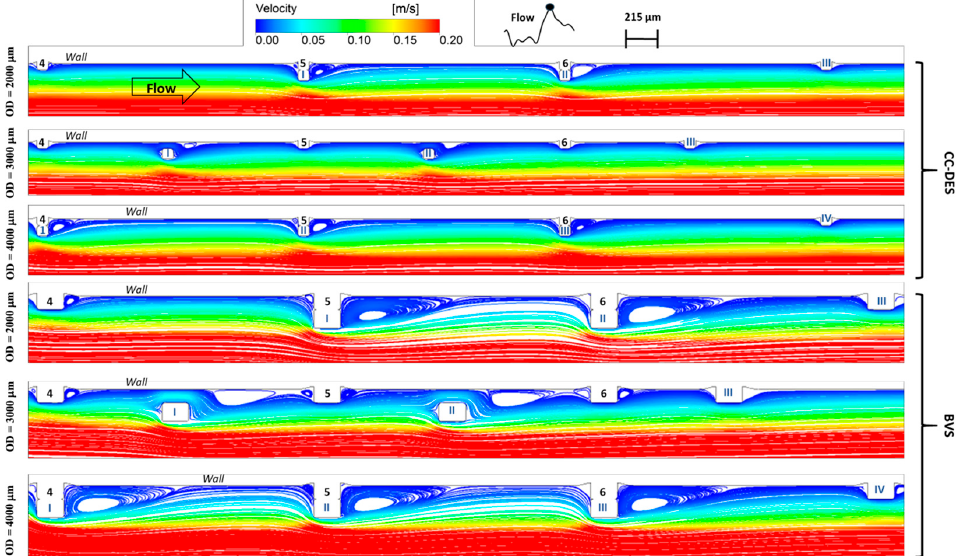
Figure 9. Streamlines at diastolic peak for overlapping stents. For simplicity reasons, just three representative configurations are presented for each strut size.